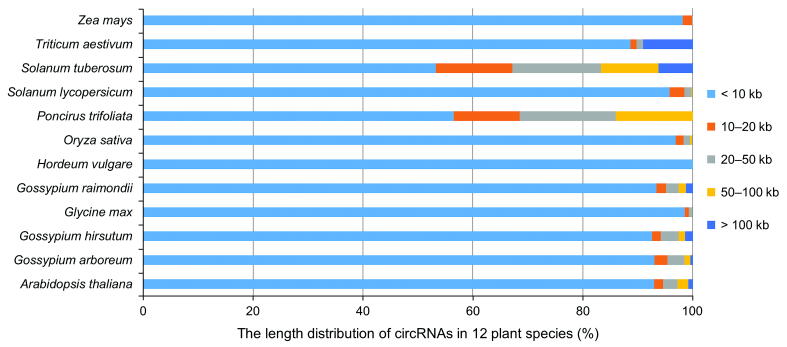
The length distribution of circRNAs in PlantCircBase.